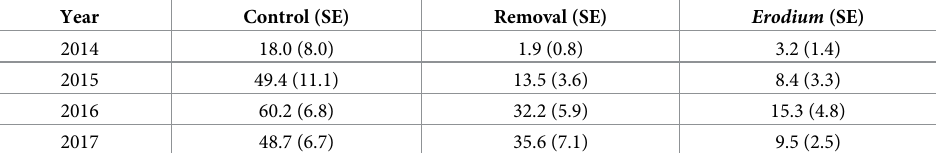
Table 1. Mean and standard error (in parentheses) values for total foliar cover of non-native grasses and forbs in control compared to removal plots over the four treatment